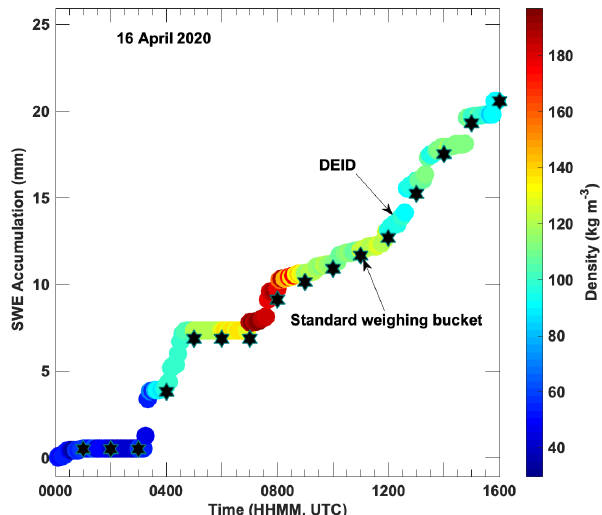
Figure 10. Time series of the SWE rate measured at a sampling frequency of 12Hz (black dots) and averaged over a 15s period (blue dots) measured on 15 April 2020 at the Alta-Collins site.